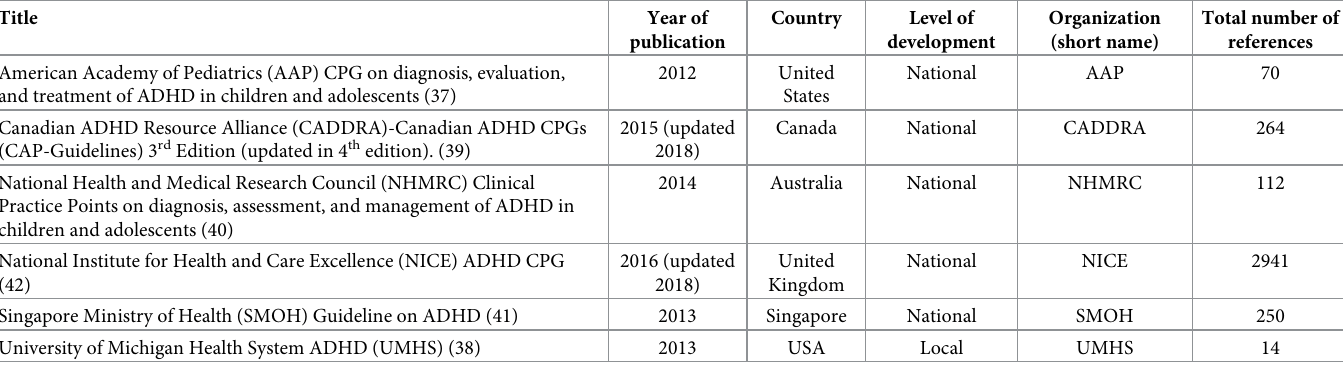
Table 1. Characteristics of the ADHD clinical practice guidelines (general).